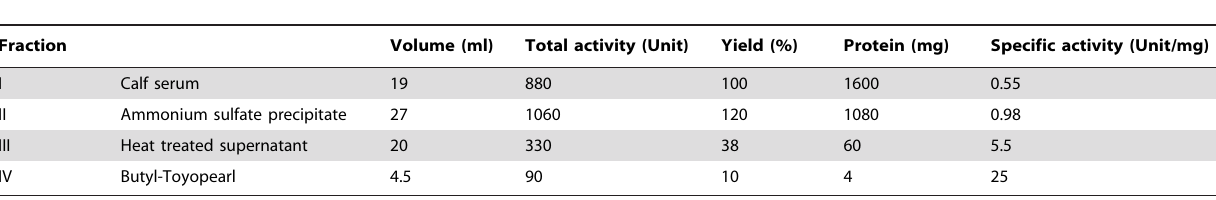
Table 2. Purification of colony-spreading stimulatory factor in calf